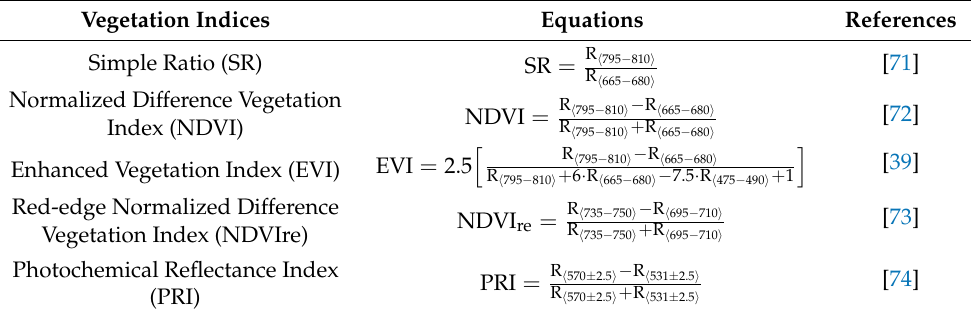
Table 1. Vegetation indices derived from HyPlant DUAL module reflectance data. R in the for- mulas represents the reflectance while the numbers refer to wavelengths in nm. Adopted after Bandopadhyay et al.